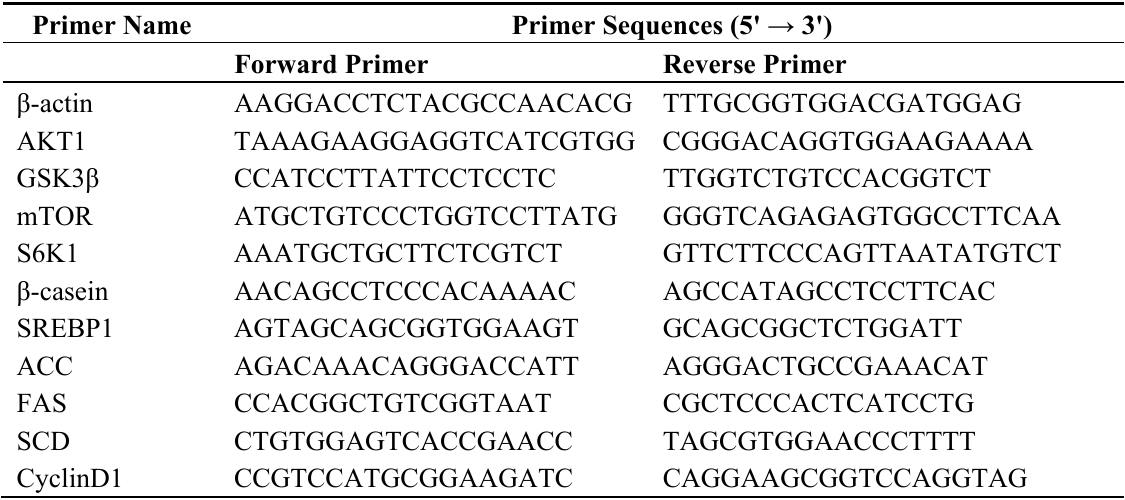
Table 1. Primer sequences for qRT-PCR